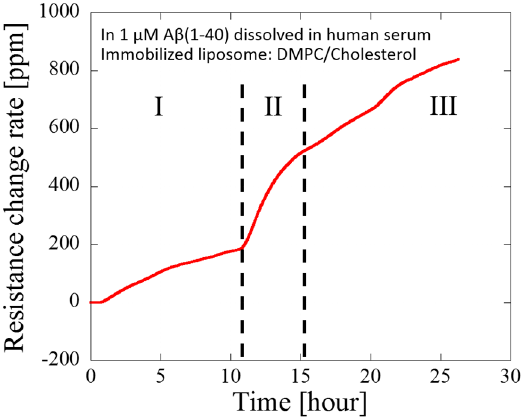
Figure 4. The change in resistance of the cantilever biosensor immobilized with DMPC/Cholesterol in 1 µM A β (1-40) dissolved in human serum: (I) monomeric A β (1-40), (II) aggregation of A β (1-40) and (III) mature A β (1-40)